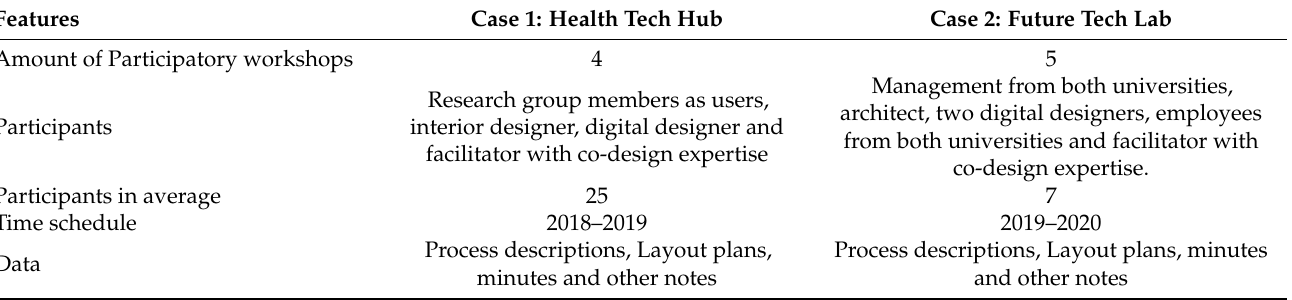
Table 3. Participatory workshops.